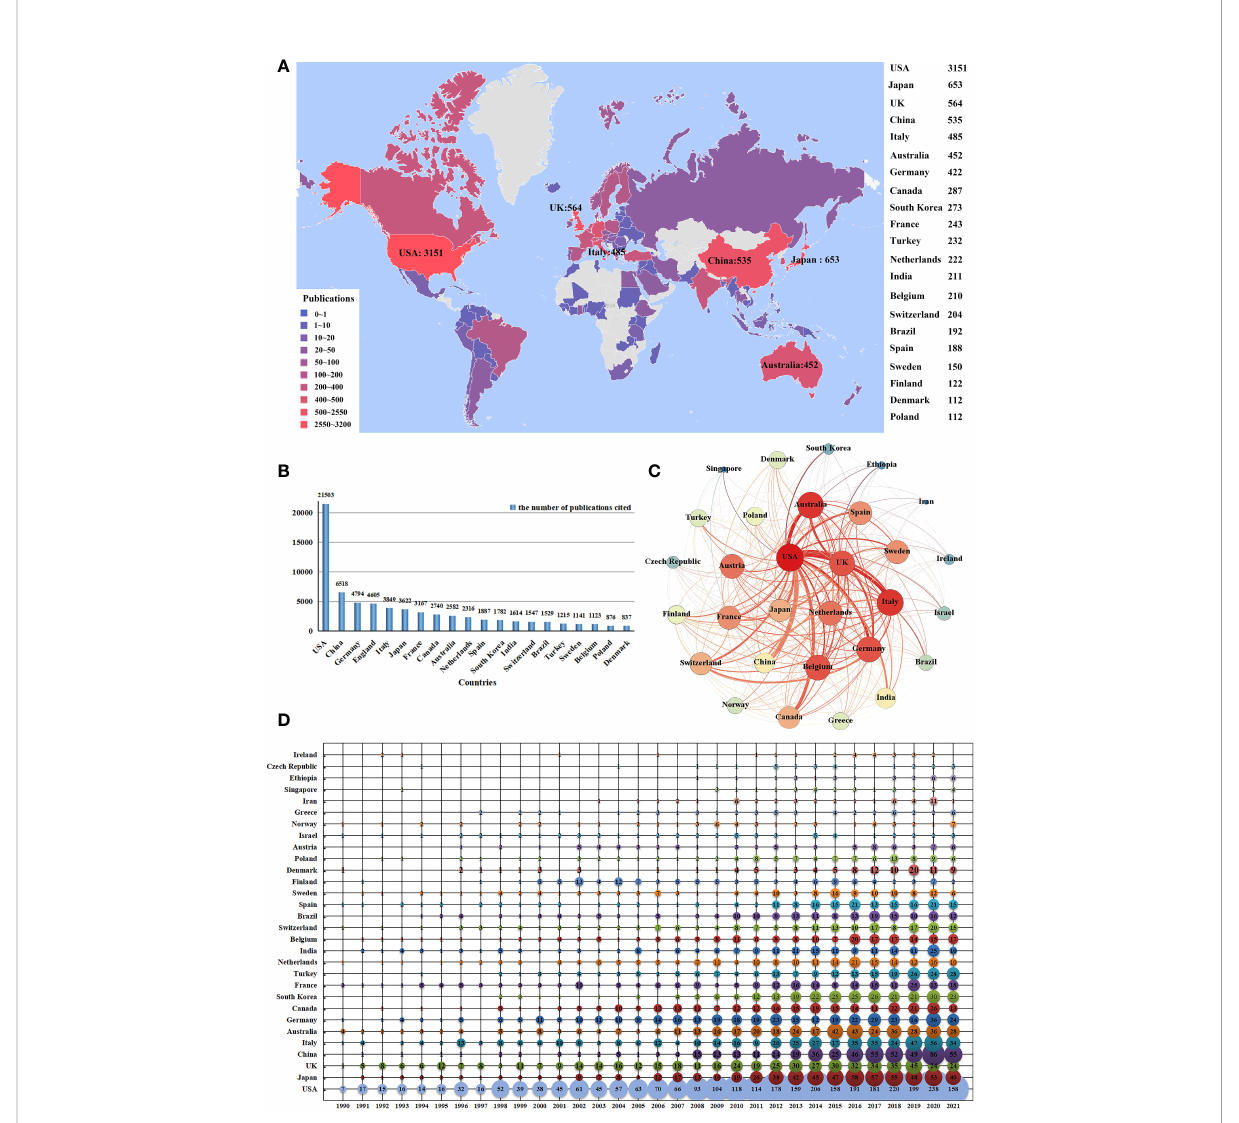
FIGURE 5 The distribution of publication output by countries. (A) The spatial distribution of top 20 most productive countries producing lymphedema publications. (B) The top 20 citing countries on lymphedema. (C) The cooperation network of co-publication of lymphedema publications among selected countries. (D) Temporal distribution of top 30 most productive countries of lymphedema